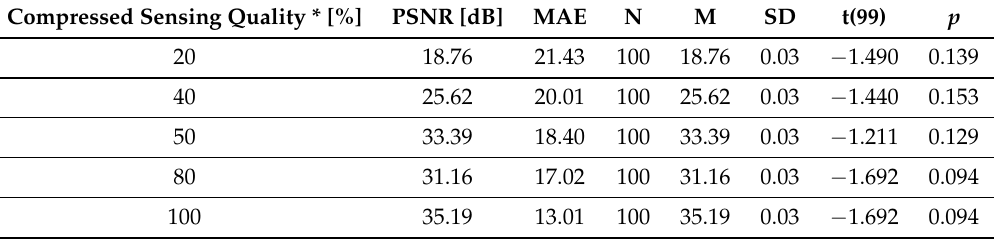
Table 5. The performance of the algorithm for the data from the Figure 6 at different Compressed Sensing quality ratios *.